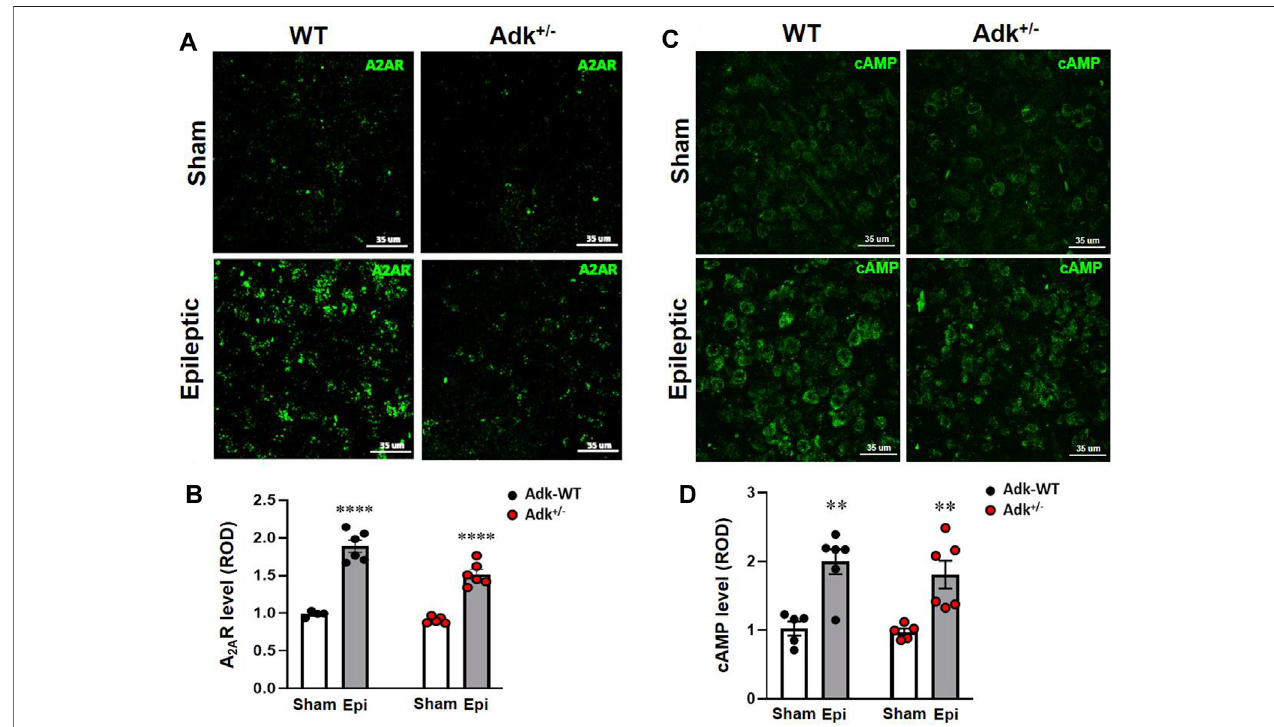
FIGURE 3| Changes ofA 2A R and cAMP in the NTS of IHKA modeled epileptic mice. Representative images ofIF stainingfor A 2A R (A) and cAMP (C) in the NTS of IHKA modeled epileptic mice (Epileptic) vs. sham controls (Sham). Quantitative analysis of the NTS densities of A 2A R (B) and cAMP (D) (presented as relative optical density, ROD) in IHKA modeled epileptic (Epi) mice vs. sham controls (Sham). Data are mean ± SEM. ** p < 0.01 and **** p < 0.0001, vs. sham controls within same genotype, unpaired t -test. Scale bar = 35 μ